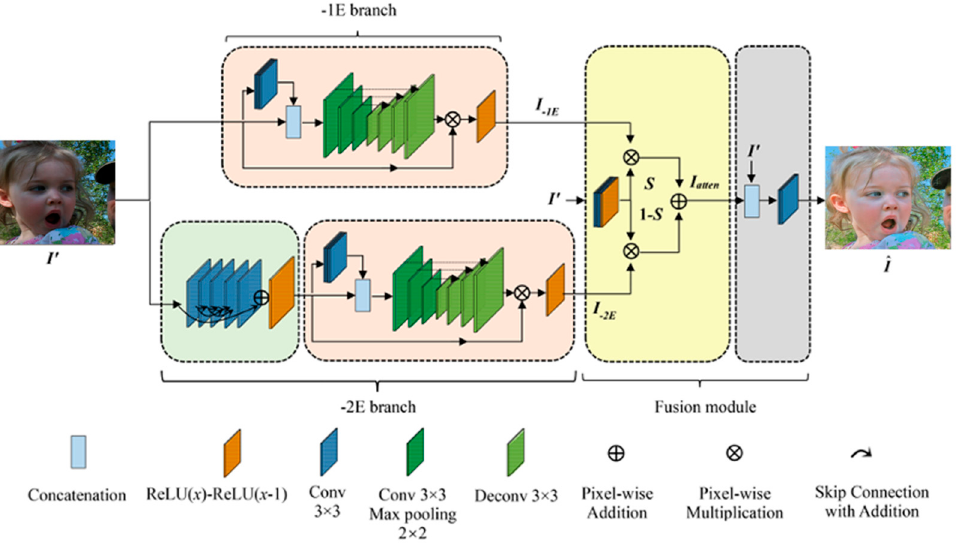
Figure 4. Structure of the network used in a model that improves images with low contrast [23]. 𝐹 (cid:3032)(cid:3041)(cid:3029)(cid:3045)(cid:3028)(cid:3041)(cid:3030)(cid:3035) independently creates the − 1E branch and the main structure of the − 2E